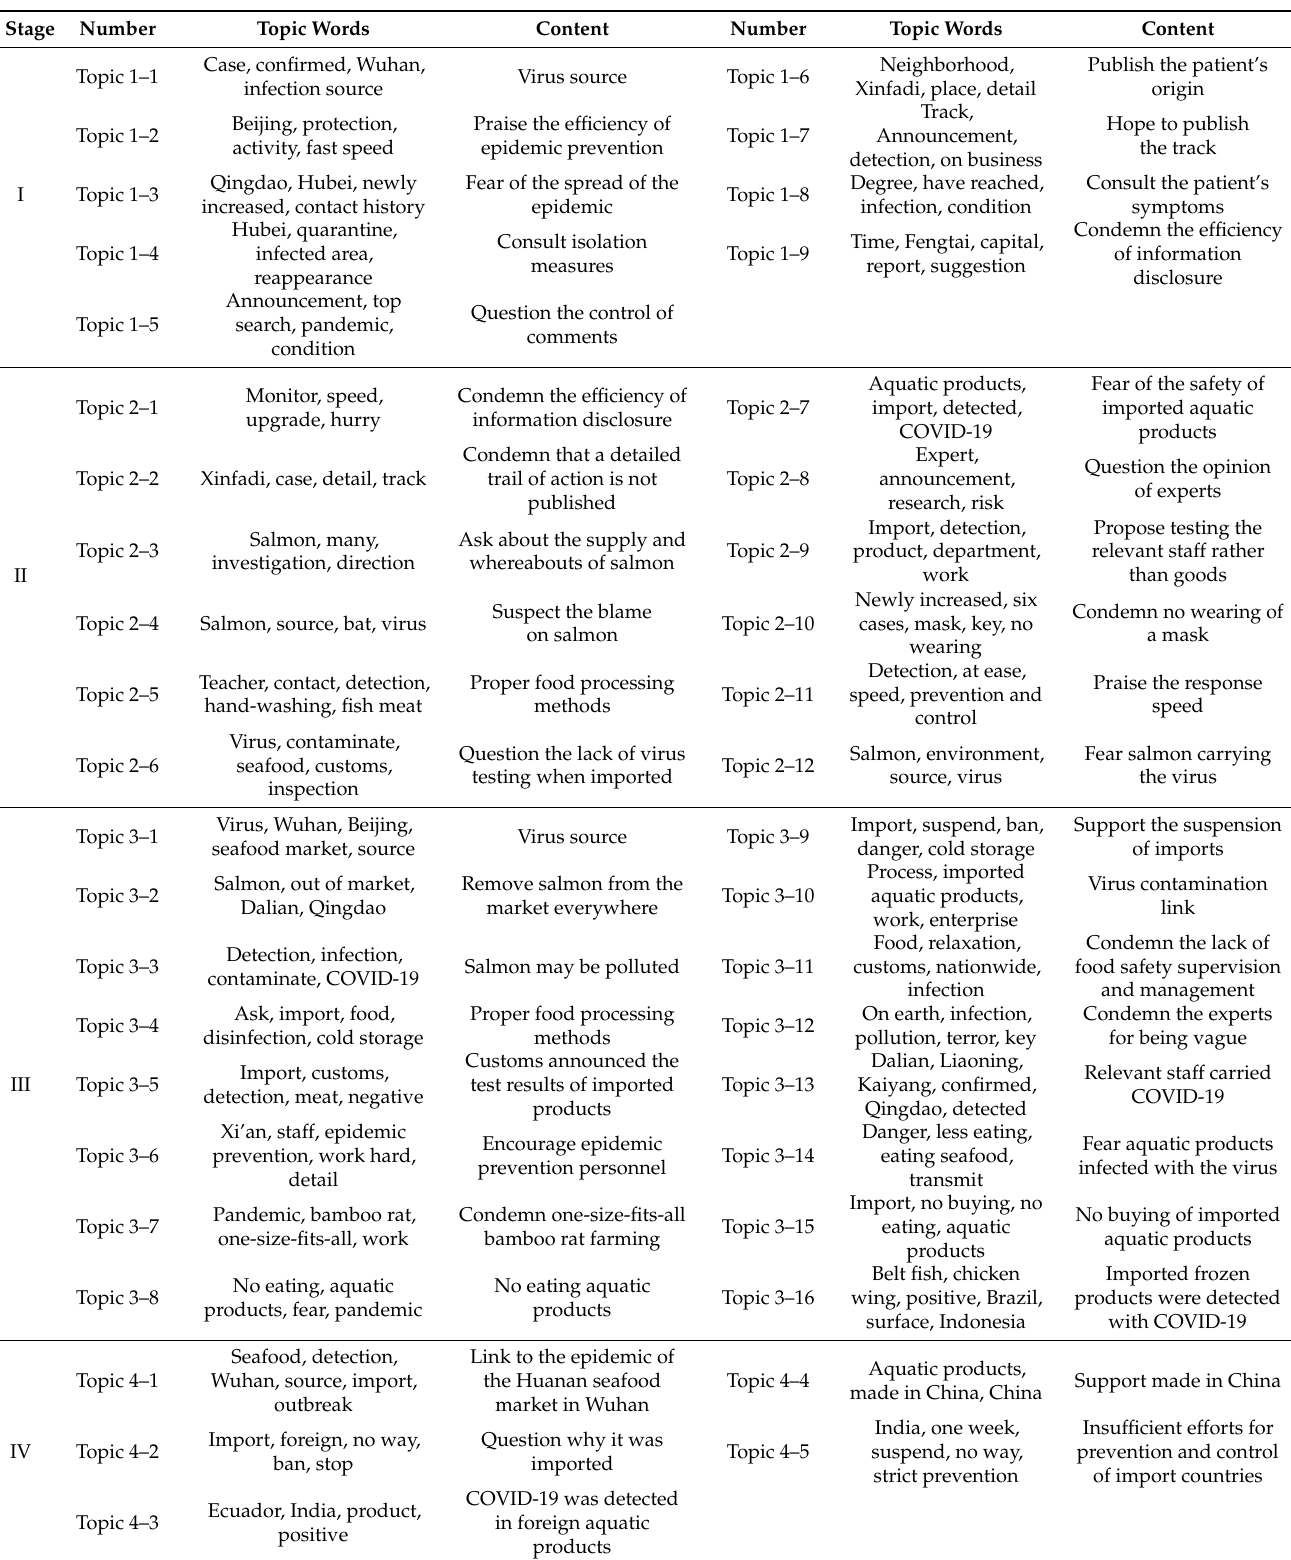
Table 2. Topic words and a summary of the content that netizens focus on at each stage of public